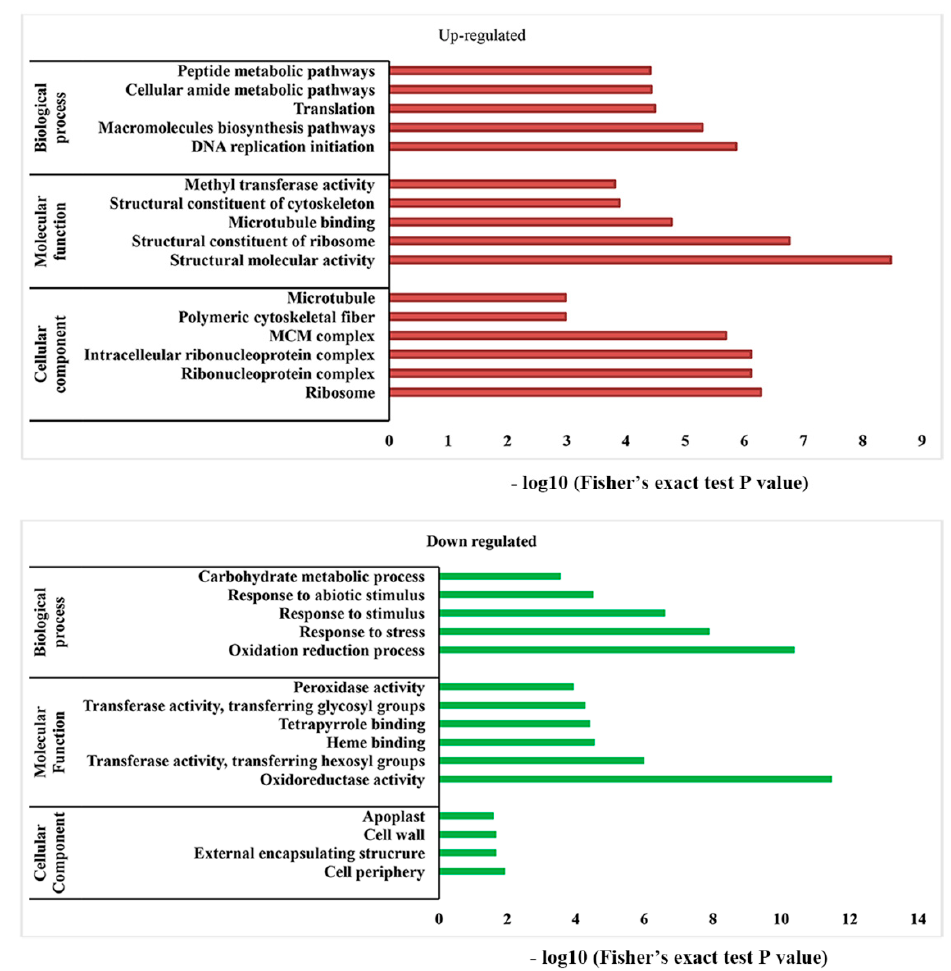
Figure 4. Gene ontology functional enrichment analysis of co-regulated genes and proteins in treated 165 and control samples. 166